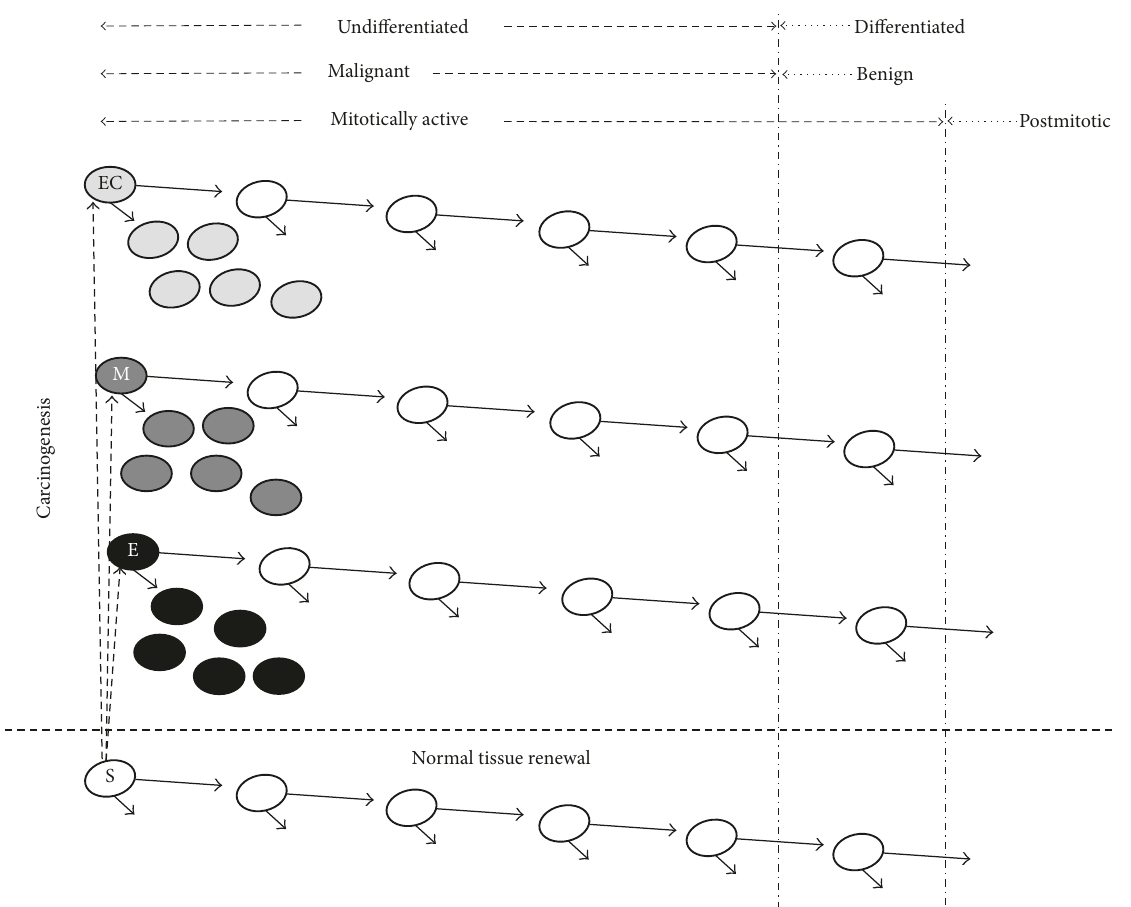
Figure 4: Embryonic model of cancer. The normal cell lineage of tissue renewal is at the bottom. The three different tumors are at the top. The different types of cancer correspond to their different embryonic origins. S: normal stem cell; E: tumor of the endodermic origin; M: tumor of the mesodermic origin; and EC: tumor of the ectodermic origin. Model adapted from the original idea of Pierce,